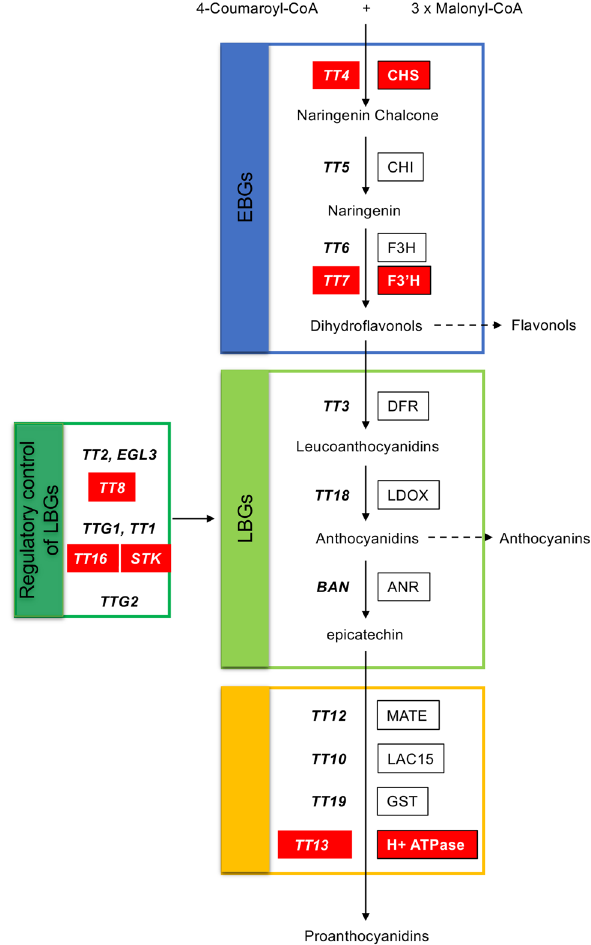
Figure 1. Schematic representation of the flavonoid biosynthetic pathway in Arabidopsis thaliana seeds. Genes encoding enzymes for each step are indicated as follows: (1) Early biosynthesis genes: TRANSPARENT TESTA 4 ( TT4 ), TRANSPARENT TESTA 5 ( TT5 ), TRANSPARENT TESTA 6 ( TT6 ) and TRANSPARENT TESTA 7 ( TT7 ), which are involved in the biosynthesis of PAs precursors and other classes of Arabidopsis flavonoids. (2) Later biosynthesis genes (LBG): TRANSPARENT TESTA 3 ( TT3 ), TRANSPARENT TESTA 18 ( TT18 ) and BANYULS/ ANTHOCYANIDIN REDUCTASE (BAN/ANR). 3) TRANSPARENT TESTA 12 ( TT12 , MATE transporter), TT10 (laccase 15), TT19 (Glutathione-S-transferase) and TRANSPARENT TESTA 13 ( TT13 ). The regulatory control of LBGs requires the action of a MBW transcriptional regulation complex (MYB-bHLH-WDR), formed by a specific R2R3-MYB (TT2), bHLH transcription factors ( EGL3, TT8 ) and a WD repeat protein TRANSPARENT TESTA GLABRA 1 ( TTG1 ). Other transcription factors belonging to different families such as C2H2 and C2HC zinc finger ( TT1/WIP1 ), MADS-box ( ABS/TT16/AGL32, STK ) and WRKY ( TTG2/DSL1/ WRKY44 ) also participate in their